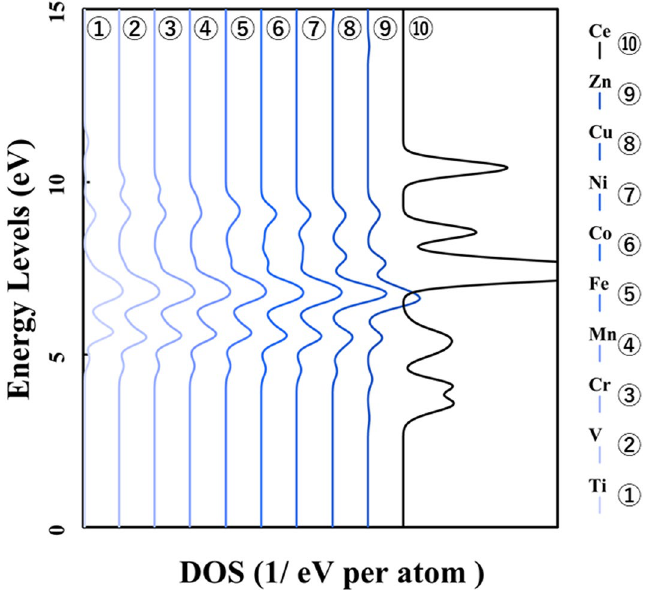
Figure 2. p-DOS for the 2p orbitals of the oxygen atoms in the M@Ce 12 O 836+ cluster model, the vacuum level is the reference energy level (M = Ti, V, Cr, Mn, Fe, Co, Ni, Cu, Zn,